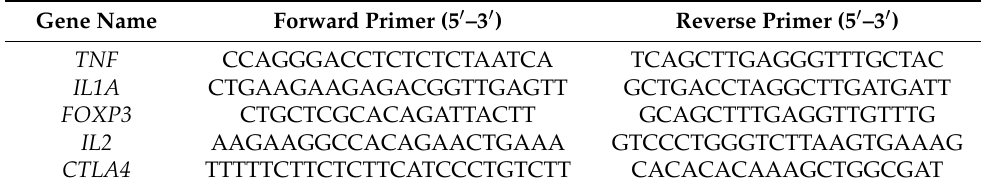
Table 5. Primer sequences used in the